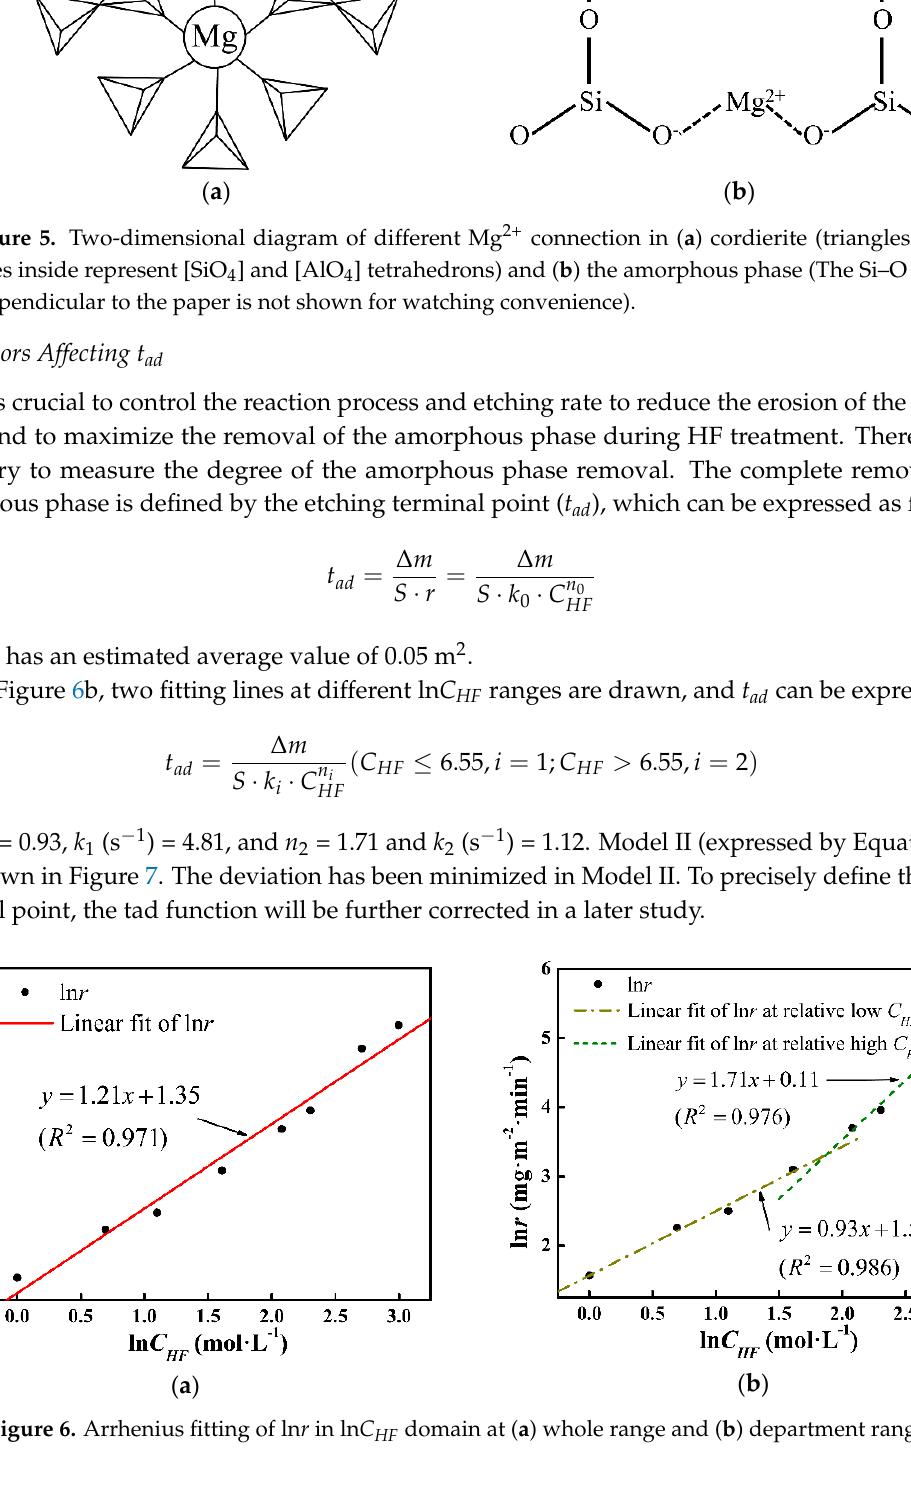
Figure 7. Data fit on Model I and II. According to Equation (1), Figure 6a presents the Arrhenius curve of ln r vs. ln C HF . The slope of the fitting line corresponds to the reaction order and the intercept exhibits the logarithm of the rate constant, which are n 0 = 1.21 and k 0 = 3.86, respectively. Model I (expressed by Equation (4)) and the experimental t ad data are shown in Figure 7. It can be seen that the measured data fit Model I in low